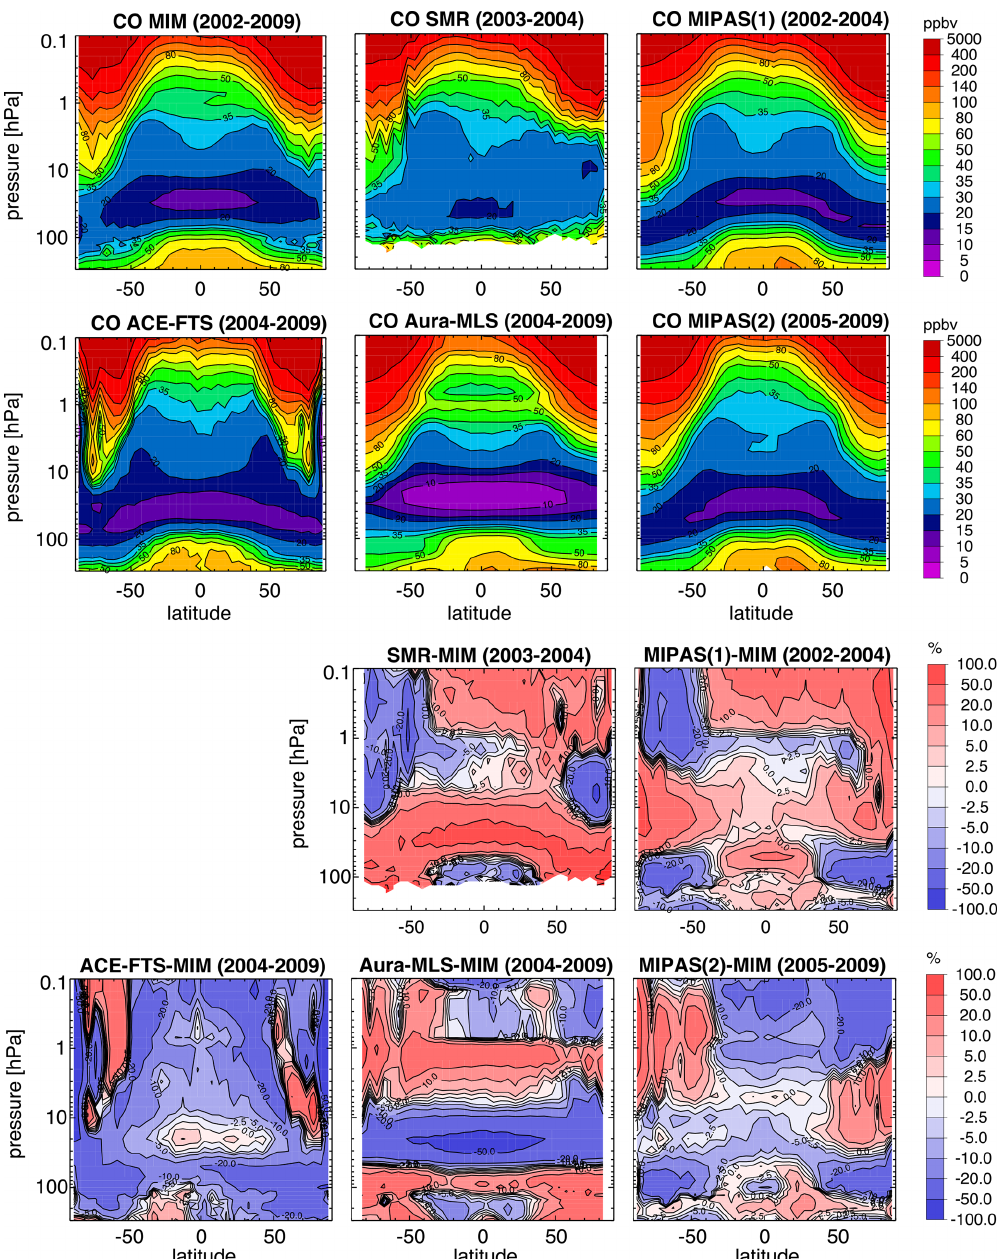
Figure 10. Annual zonal mean CO cross sections are shown for the MIM, SMR, MIPAS(1), ACE-FTS, MIPAS(2), and Aura-MLS averaged over 2002–2009 (upper half). Also shown are the relative differences between the individual instruments and the MIM (lower half). Note that SMR and MIPAS(1) are excluded from the calculation of the